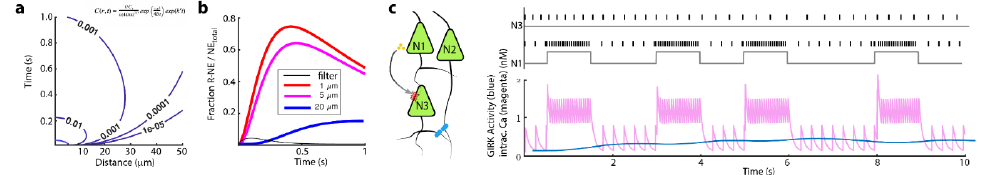
Figure 5. Spike modulation in the neighboring neuron of somatically release NE cumulatively affects neighboring neurons within a 25 μm radius . ( a ) Spatiotemporal diffusion profiles of NE from a point source. The diffusion constant for NE was 3.4 × 10 −6 cm 2 s −1 [15,17]. ( b ) Time course of fractions of NE bound alpha2-receptor at 1, 5, and 20 μm distance s from release site. Kinetics of transmitter binding and release was modeled by an alpha function (think black line, τ = 50 ms). ( c ) Simulation of spike train of current injected neurons (N1) and nearby neurons (N3/25 μm distance). The lower plot shows the development of intracellular calcium levels in N1, while the blue line represents GIRK conductance in N3.